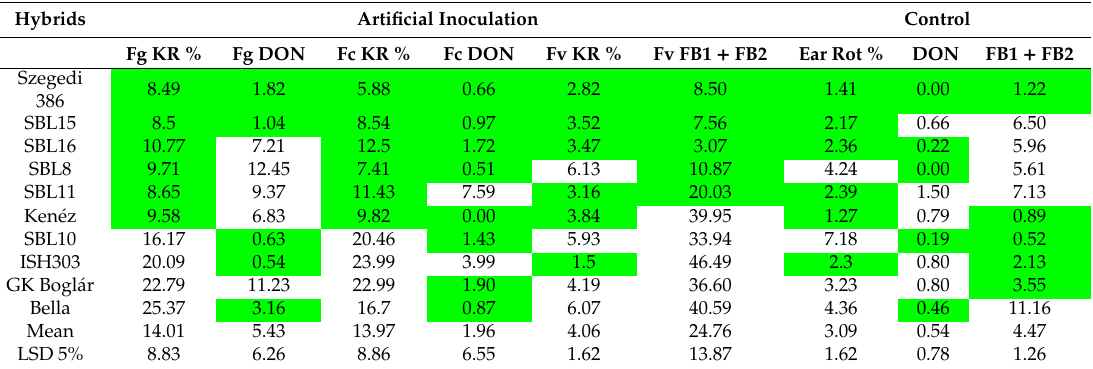
Green highlighted: Value is lower than the column mean. NI control: naturally infected control. Table 21. Kernel resistance to maize ear rots, correlation analysis from data of Table 20.